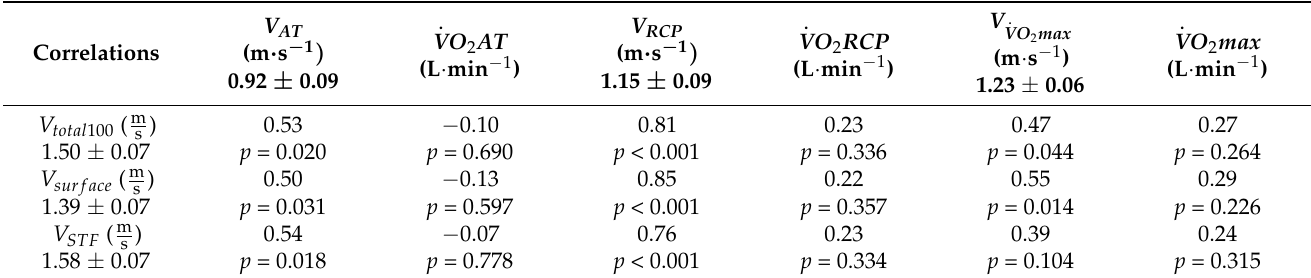
Table 4. Correlations of stage test physiological and kinematics indices V AT , VO 2 AT , V RCP , VO 2 RCP , V . . VO 2 max with V total 100 , V surface , V STF .